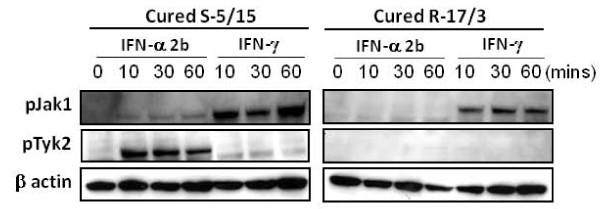
IFN-α dependent activation of Tyk2 and Jak1 is prevented in resistant Huh-7 cells. Cured S-5/15 and R-17/3 cells were treated with IFN-α 2 b (1000 IU/ml) or IFN-γ (1000 IU/ml) for different time intervals 10, 30 and 60 minutes and cell lysates were examined for Jak1 and Tyk2 phosphorylation by Western blot analysis. Left panel shows the time dependent phosphorylation of Jak1 and Tyk2 kinases in sensitive Huh-7 cells (S-5/15) by IFN-α and IFN- γ (1000 IU/ml). Right panel shows the phosphorylation of Jak1 and not Tyk2 in resistant Huh-7 cells (R-17/3) by IFN-α and IFN-γ (1000 IU/ml). β-actin levels are the same among the protein samples analyzed.